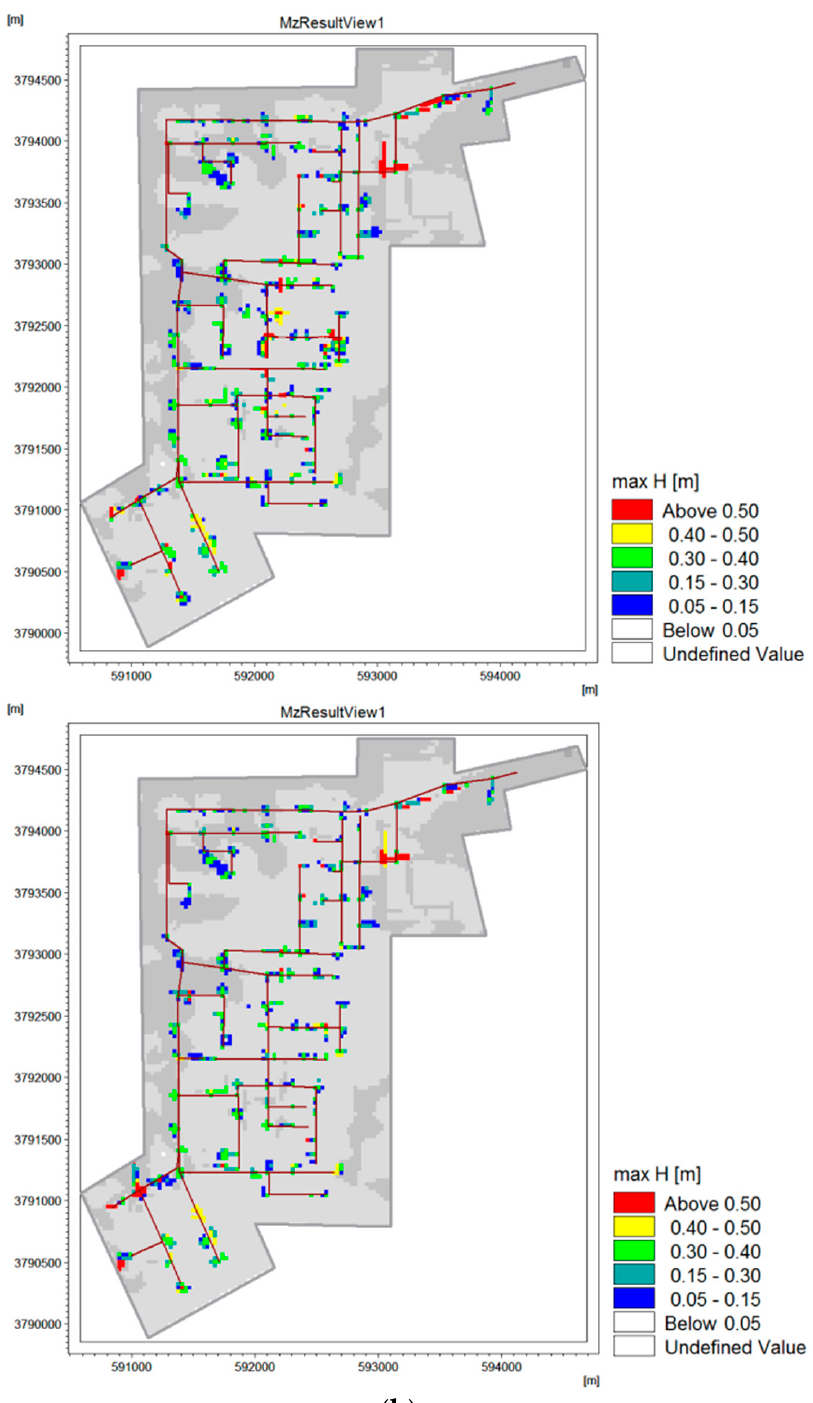
Figure 5. Distribution of rainstorm waterlogging at different maximum submerged depth. ( a ) Distribution of rainstorm waterlogging at different maximum submerged depth during the 5- year recurrence interval with no rain garden and rain garden regulation; ( b ) Distribution of rainstorm waterlogging at different maximum submerged depth during the 20-year recurrence interval with no rain garden and rain garden regulation.